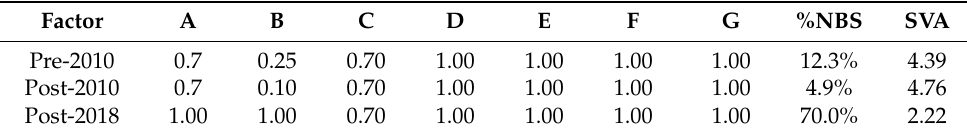
Table 14. Summary of the seismic vulnerability assessment (SVA)